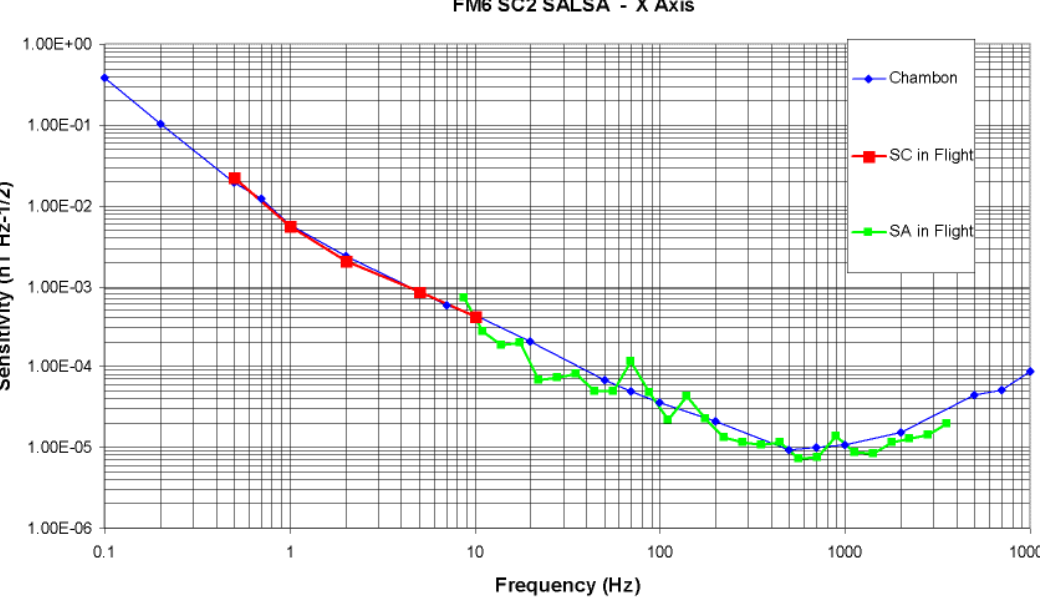
Fig. 2. STAFF search coils and analyser sensitivity. Comparison of ground measurements (blue curve) at the output of the preamplifier in the quiet site of Chambon la Forˆet and in-flight measurements performed in a quiet region, the lobes, at the output of the waveform analyser (red curve) and the Spectrum Analyser (green). The peaks on the green curve are small WEC internal